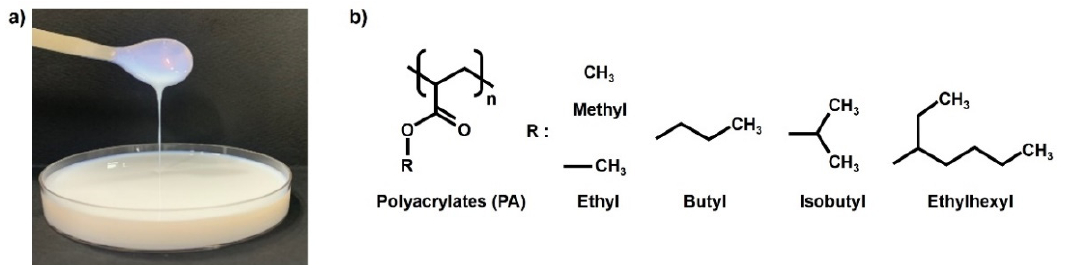
Figure 5. ( a ) Photograph of acrylic binder used in this work and ( b ) the chemical structures of rep- resentative polyacrylates.